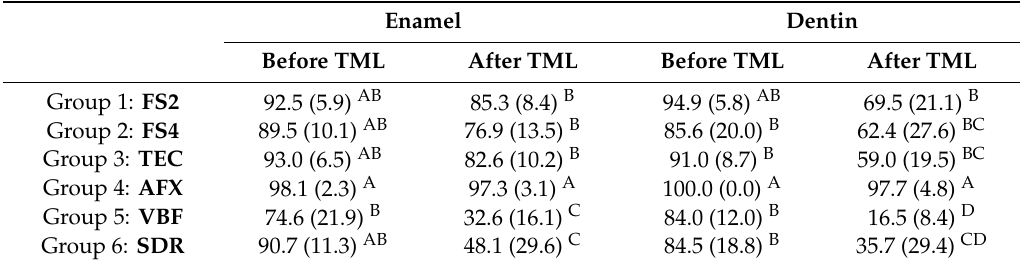
Means followed by same superscript letters per column are not significantly di ff erent from each other at the 0.05 level. All groups, except Admira Fusion x-tra (AFX) in dentin, showed a significant decline in margin integrity after TML ( p < 0.05,